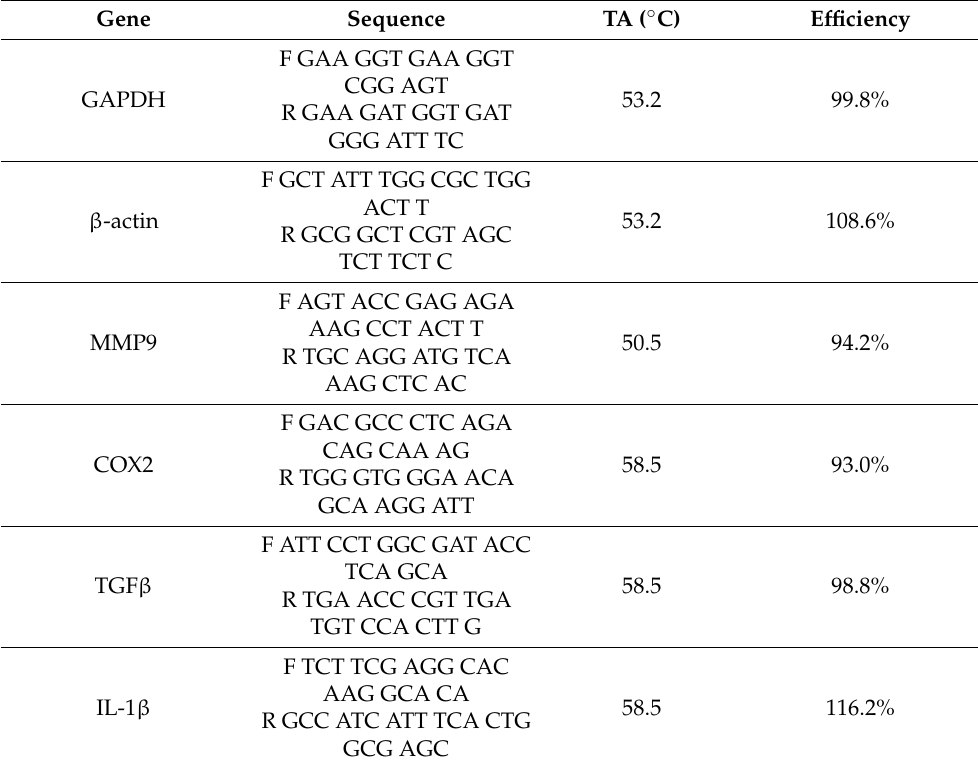
Table 2. Primer sequences of housekeeping and inflammatory genes and their annealing temperatures and efficiencies. Gene Sequence TA ( ◦ C)